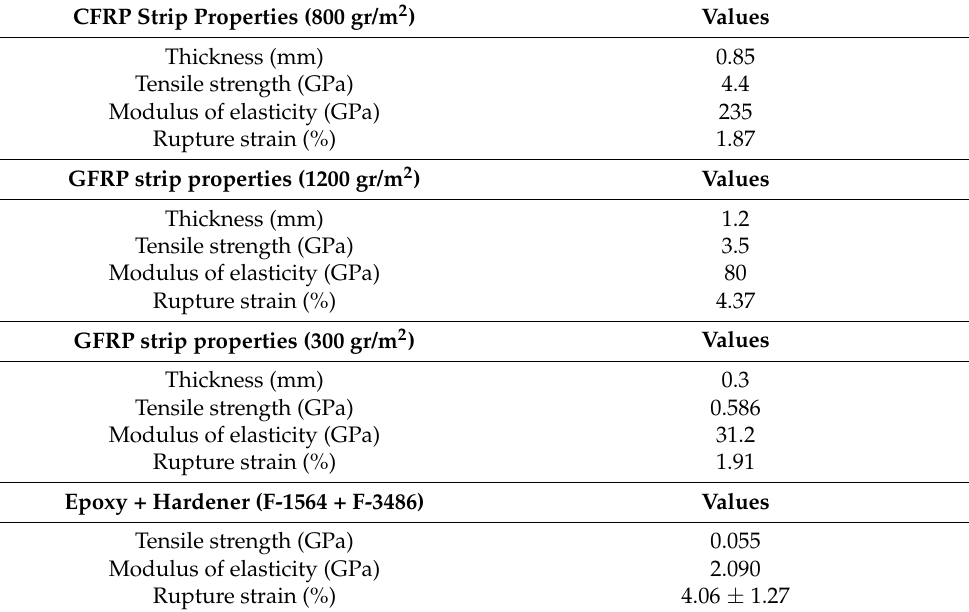
Figure 3. Test setup.